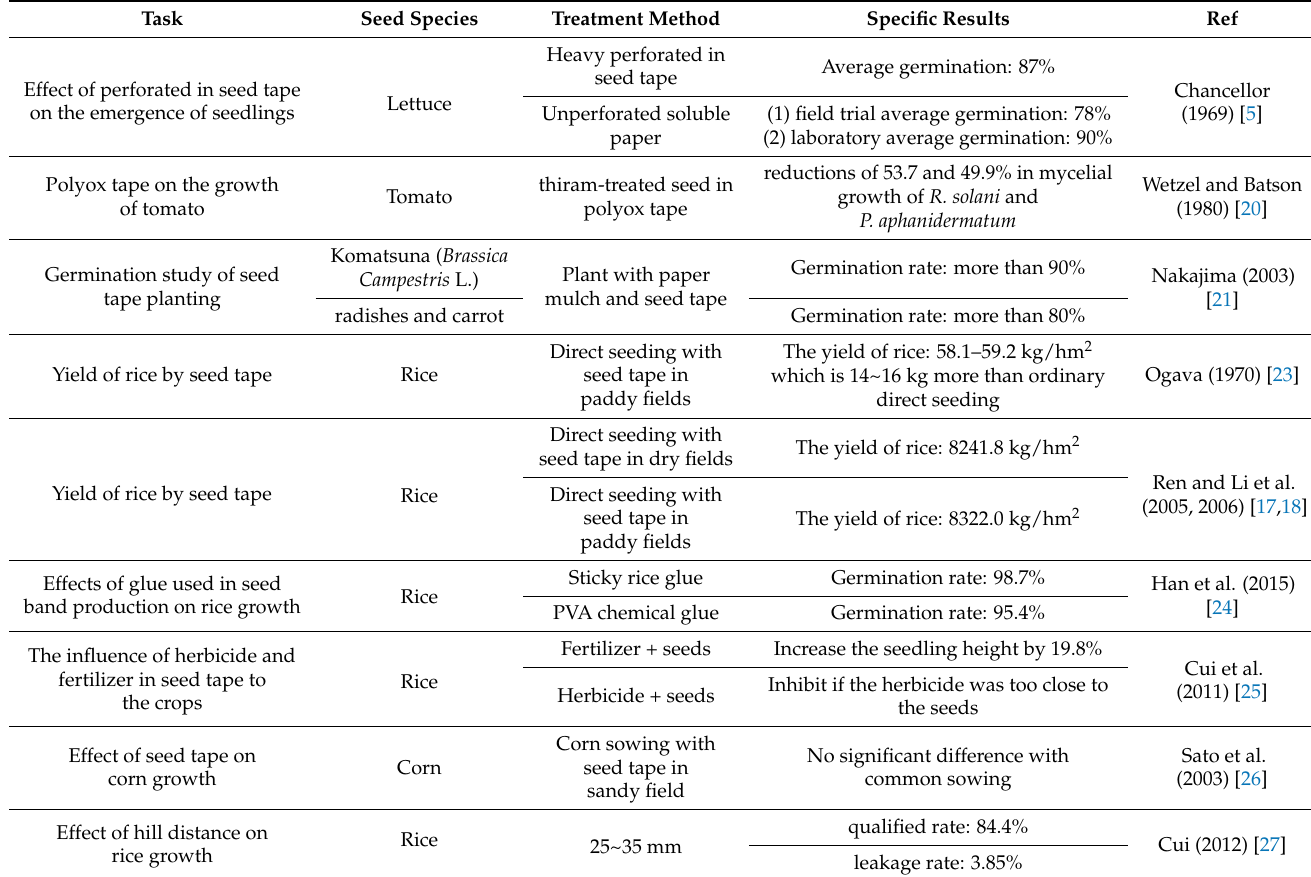
Table 1. Summarizes the specific effects of seed tape seeding on the growth of different